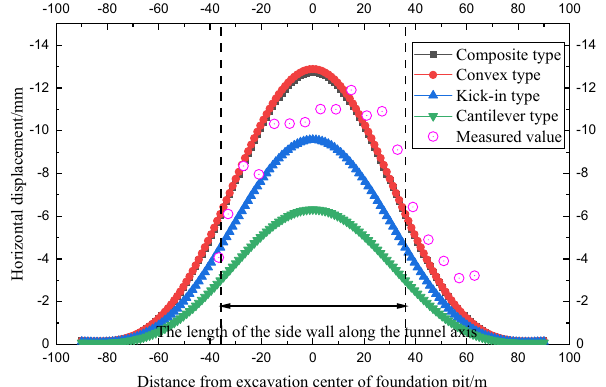
Figure 11. Comparison of tunnel deformation caused by different deformation modes of retaining structure (case